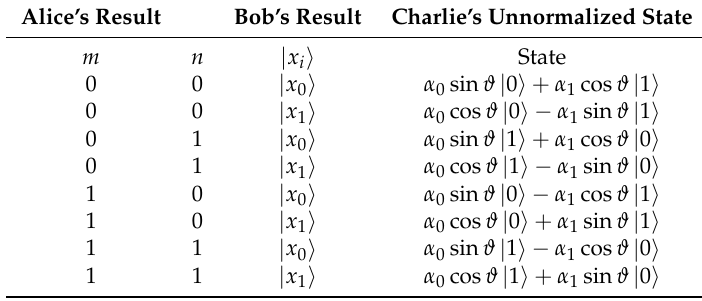
Alice’s and Bob’s measurement outcomes and corresponding projected states in Charlie’s